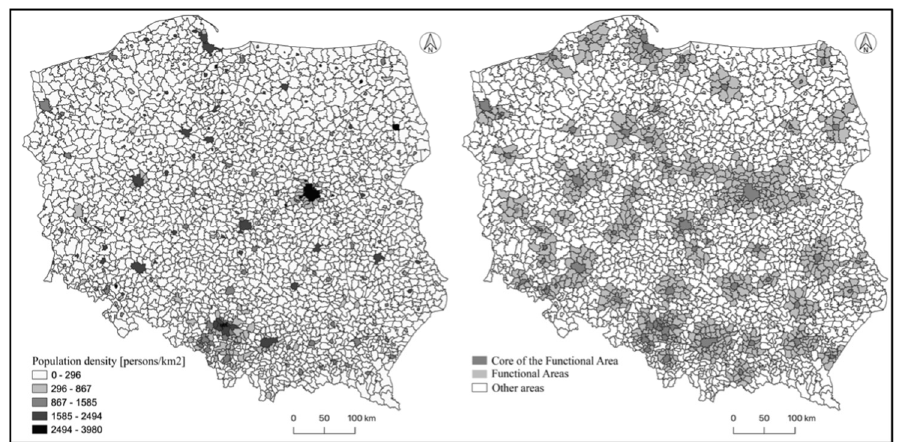
Figure 8. A map of spatial distribution of population density in 2019 and impact zones of urban functional areas in Poland (own study, based on [45,72]).